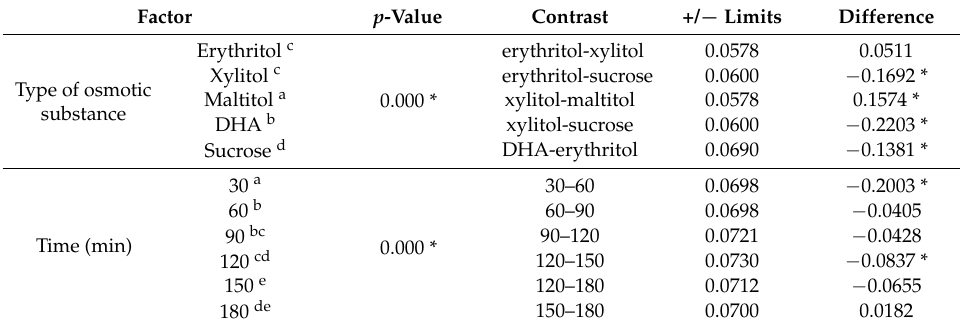
Table 5. The influence of osmotic agents and pre-treatment time on solid gain during OD. Factor p -Value